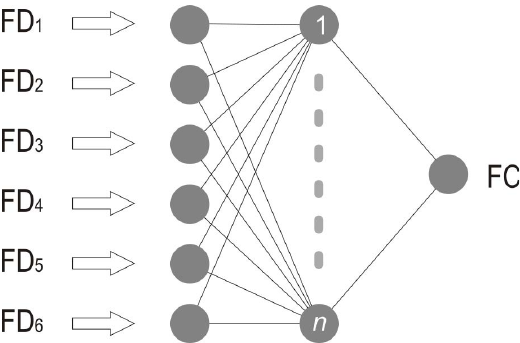
Figure 8. Input vectors of ANN with n neurons in hidden layer. Neurons between input/hidden and hidden/output layers are connected by weighted connections that produce output based on the feature vectors, weights of the connections and non-linear activation function (Figure 9).